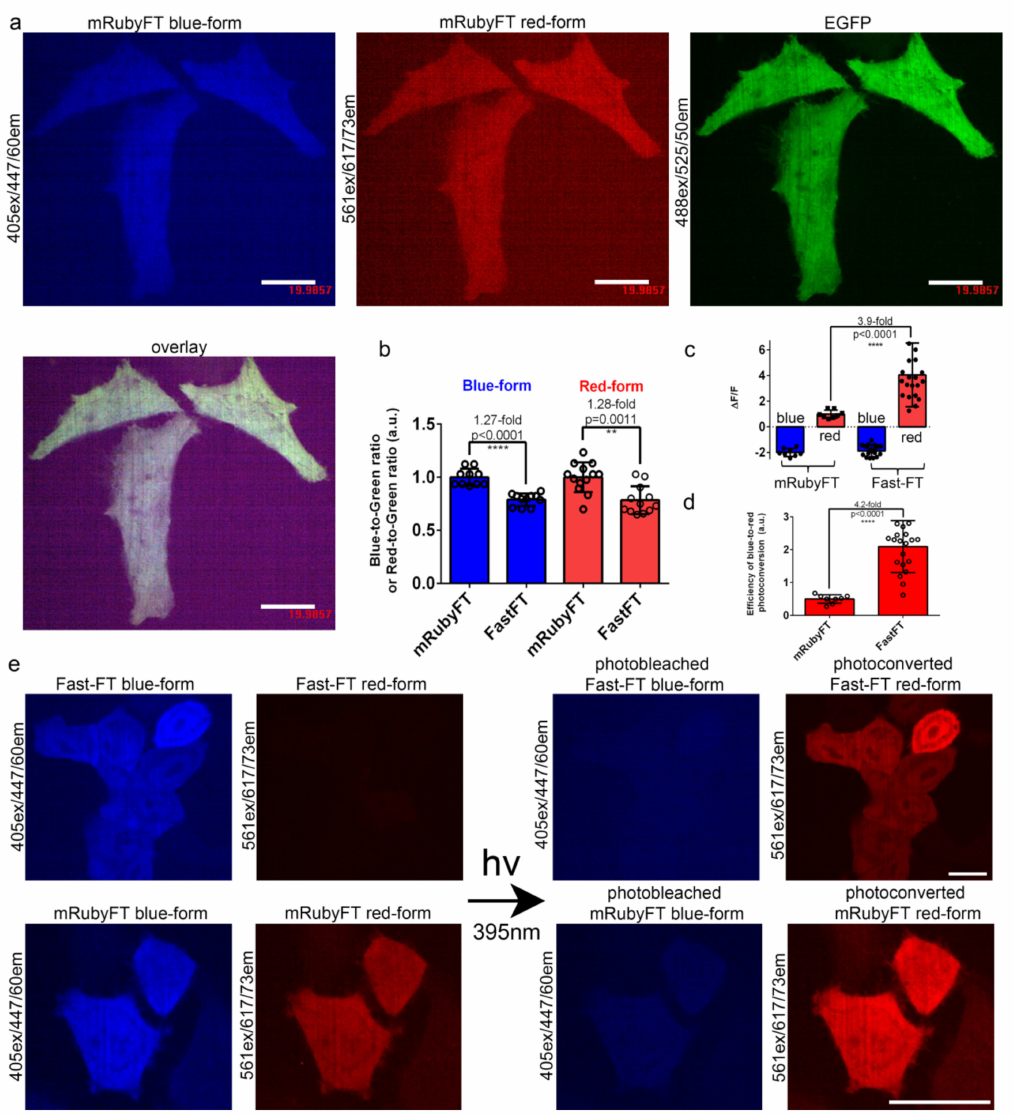
Figure 3. Comparison of the brightness and blue-to-red photoconversion of mRubyFT and control Fast-FT timers in live HeLa cells. ( a ) Confocal images of live HeLa cells expressing mRubyFT- P2A-EGFP fusion. P2A is a self-cleavable peptide. Blue (405ex and 447/60em), green (488ex and 525/50em), and red (561ex and 617/73em) fluorescence channels and their superposition are shown. ( b ) The averaged brightness for the blue and red forms for the mRubyFT and Fast-FT timers in HeLa cells normalized to the brightness of the EGFP protein expressing in the same cell. Error bars are standard deviations across 10–13 cells. ( c ) The mean ∆ F/F values for photobleached blue form and photoconverted red form of mRubyFT and control Fast-FT timers expressed in live HeLa cells 24 h after transfection. The pulse of 395/25 nm light (0.9 mW/cm 2 power measured before 60x oil objective lens) lasted for 1 min. Error bars are standard deviations across 8–20 cells. ( d ) Efficiency of the blue- to-red photoconversion with 395/25 nm light during 1 min was calculated as a ∆ F/F red / ∆ F/F blue . ( e ) Confocal images of live HeLa cells expressing mRubyFT-P2A-EGFP or Fast-FT-P2A-EGFP fusion. Blue (405ex and 447/60em) and red (561ex and 617/73em) fluorescence channels before and after irradiation with 395/25 nm light of 1 min duration are shown. Protein expression lasted 72 h. For red and blue images, the contrast settings were the same. Images were acquired 72 h ( a,b ) or 24 h ( c – e ) after transfection. ( b – d ) p values show statistical difference between the respective values. ****, p value is < 0.0001. **, p value is < 0.01. ( a,e ) Scale bars: 20 µ